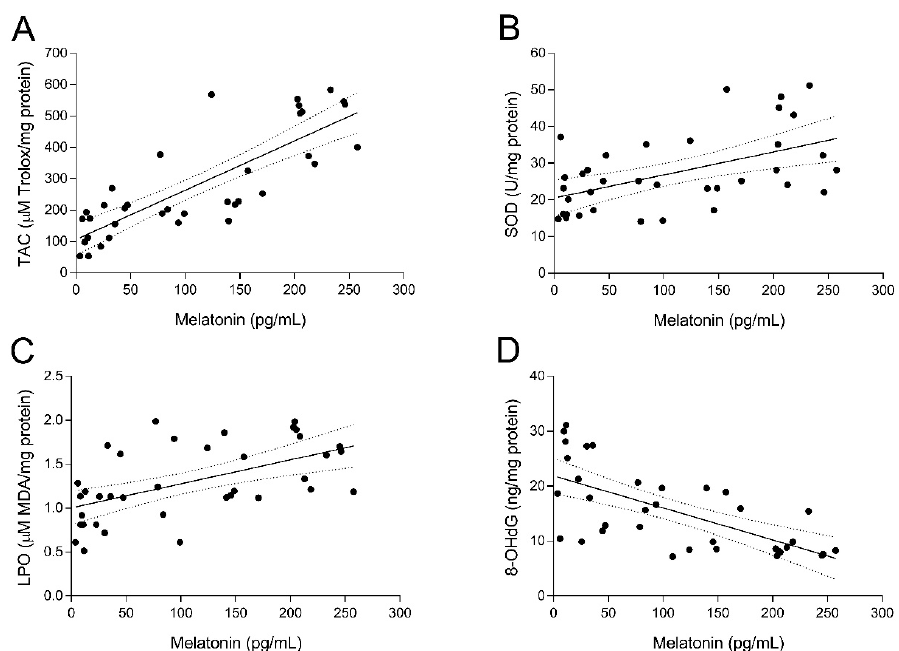
Figure 3. Relation between the intrafollicular concentrations of melatonin and di ff erent biomarkers of oxidative balance. Pearson’s correlation between intrafollicular concentrations of melatonin and intrafollicular total antioxidant capacity (TAC) ( A ), superoxide dismutase (SOD) activity ( B ), lipid peroxidation (LPO) ( C ), and 8-hydroxy-2 (cid:48) -deoxyguanosine (8-OHdG) concentrations ( D